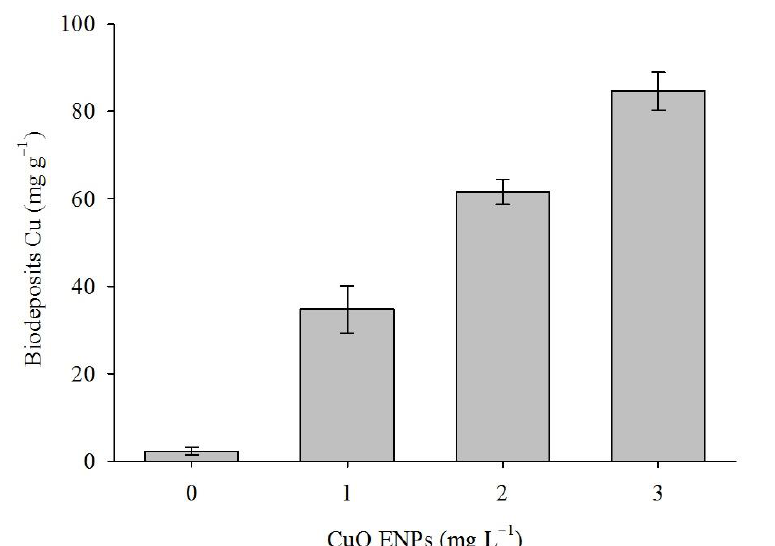
Figure 2. Excretion of Cu in mussels exposed to CuO ENPs. Mean Cu concentration in biodeposits collected from mussels exposed to CuO ENPs for four weeks. Cu concentration in biodeposits increased with increasing CuO ENP concentration (OLS: Excretion = 0.83 + 27.48 (Concentration) + 1.47 (Time), r 2 = 0.85). Error bars are one standard error of the mean.